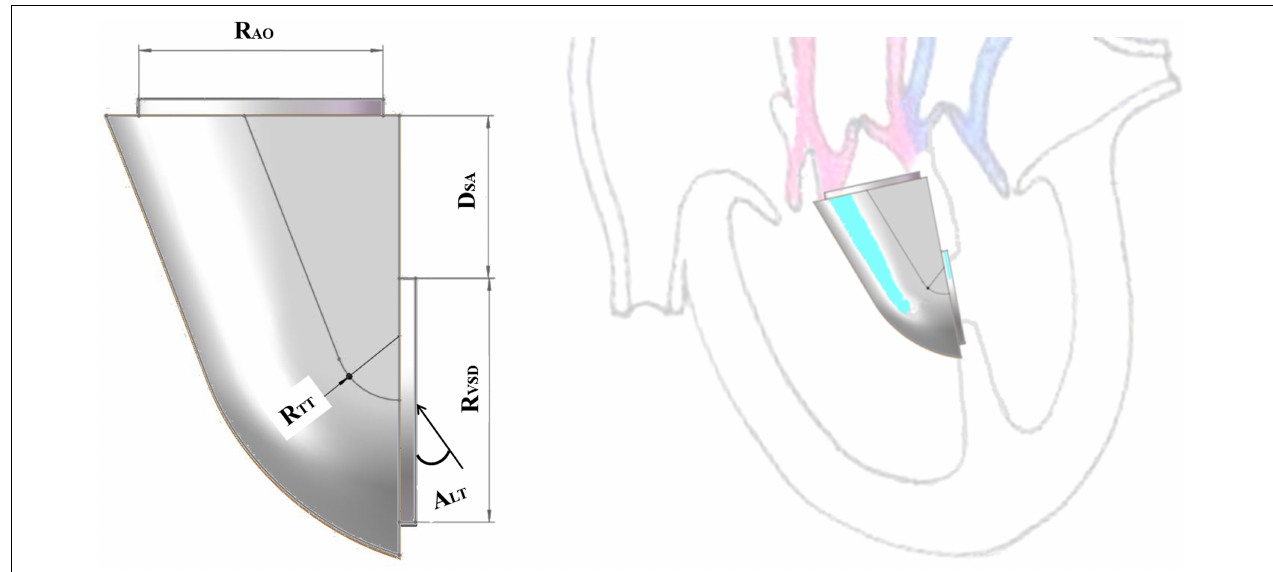
FIGURE 1 | (A) Idealized IVT geometry; (B) . IVT assembly diagram.